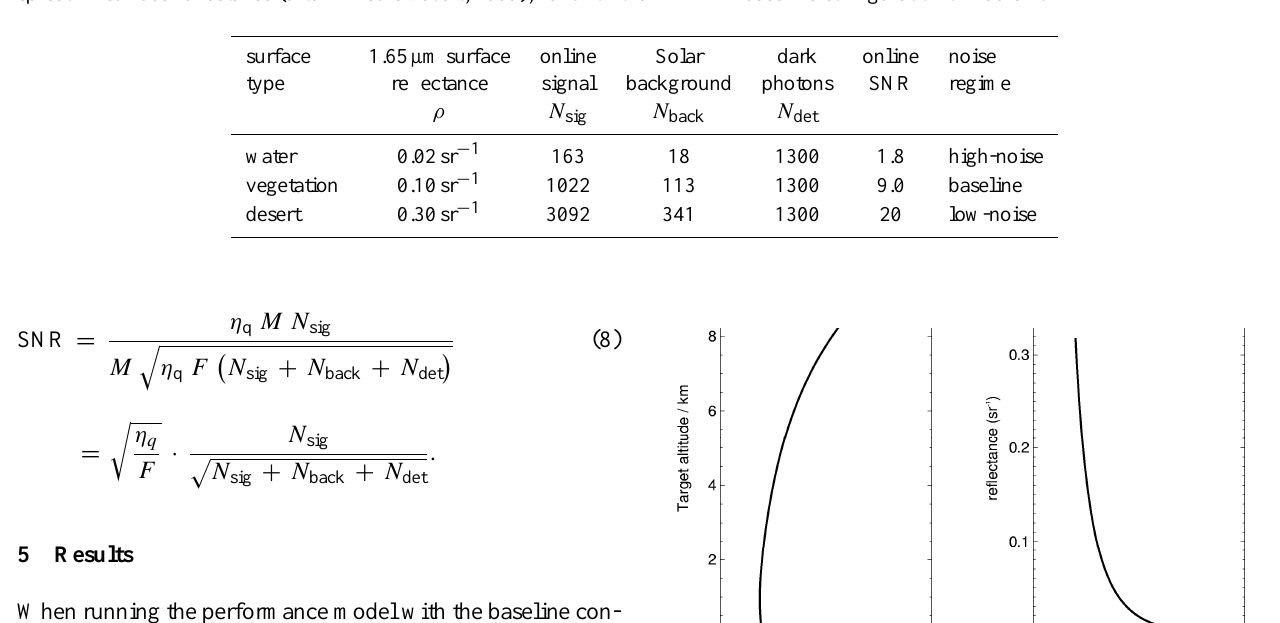
Table 3. Number of photons per range gate ( τc /2=16.7m) reaching the detector for three different regimes of noise representing the global spread in surface reflectance (after Amediek et al., 2009), valid for the MERLIN baseline configuration of Table 2.